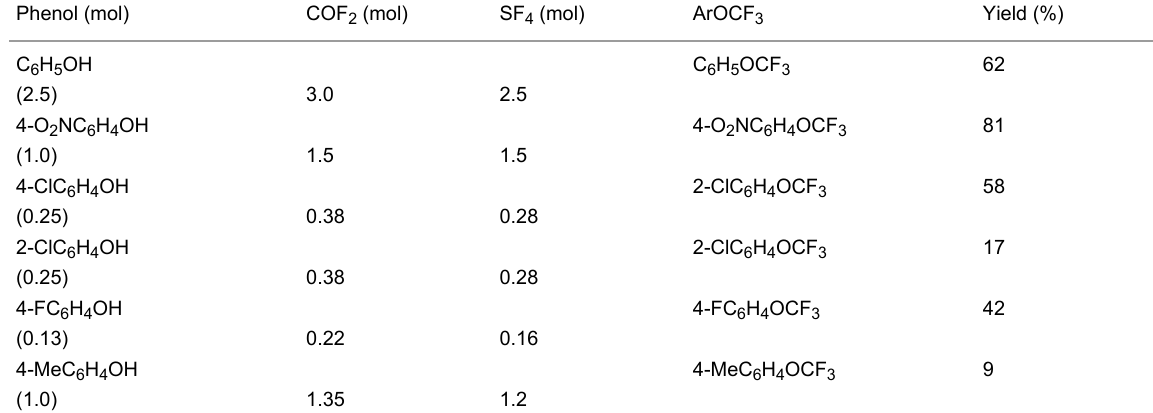
Table 4: Preparation of aryl trifluoromethyl ethers by two-step method from phenols a . Phenol (mol)